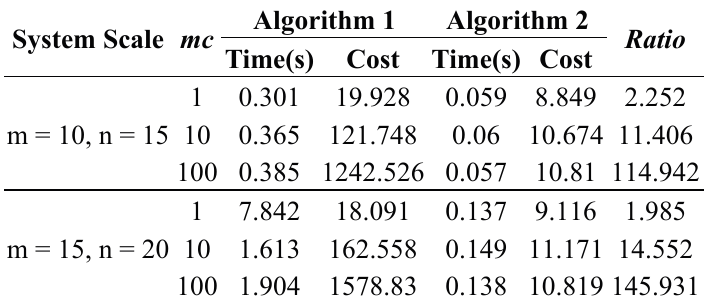
Table 3. Simulation result for the perfect test cases (N = 10, L =